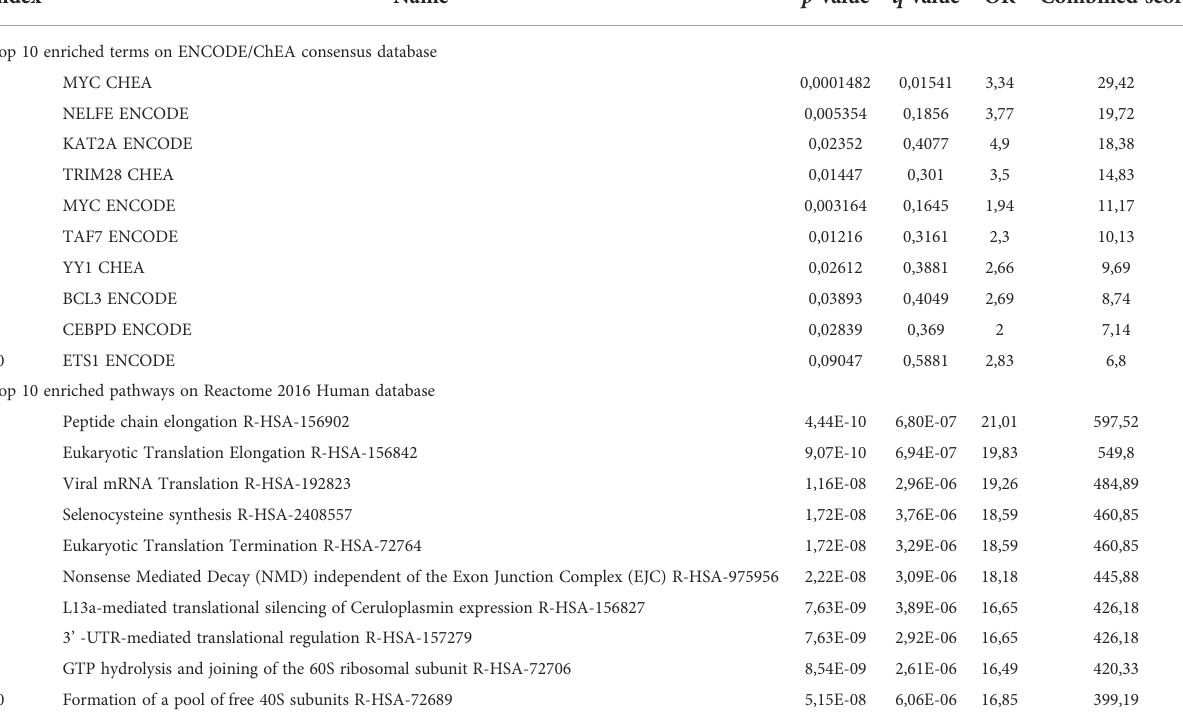
TABLE 5 Pathway analysis on EnrichR of upregulated